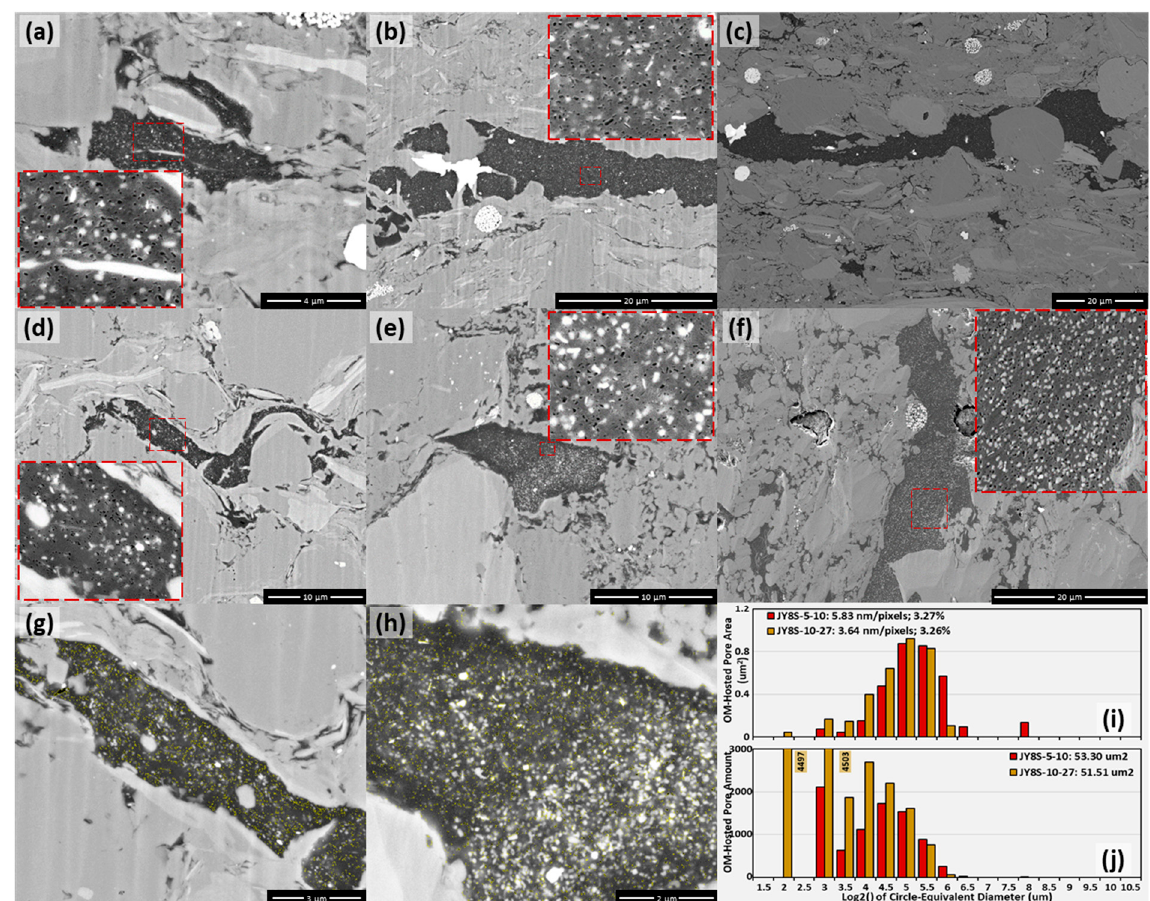
Figure 19. Examples of the amorphous kerogen rich of small bright minerals (OM IX) from Longmaxi-Wufeng Shale, Sichuan Basin. ( a ) SEM image JY8S-3-02 (well ID-sample no.-image no.); ( b ) SEM image JY8S-3-39; ( c ) SEM image JY8S-10-21; ( d ) SEM image JY8S-5-09; ( e ) SEM image JY8S-10-26; ( f ) SEM image JY1S-27-1; (g) SEM image JY8S-5-10, a near view of JY8S-5-09 with pores highlighted by yellow; ( h ) JY8S-10-27, a near view of JY8S-10-26 with pores highlighted by yellow; ( i ) pore size distribution of OM-hosted pores determined by pore area; ( j ) pore size distribution of OM-hosted pores determined by pore amount. The red rectangle indicates the location of the near view of SEM images. Organic pores in (g) and (h) were highlighted using yellow lines.